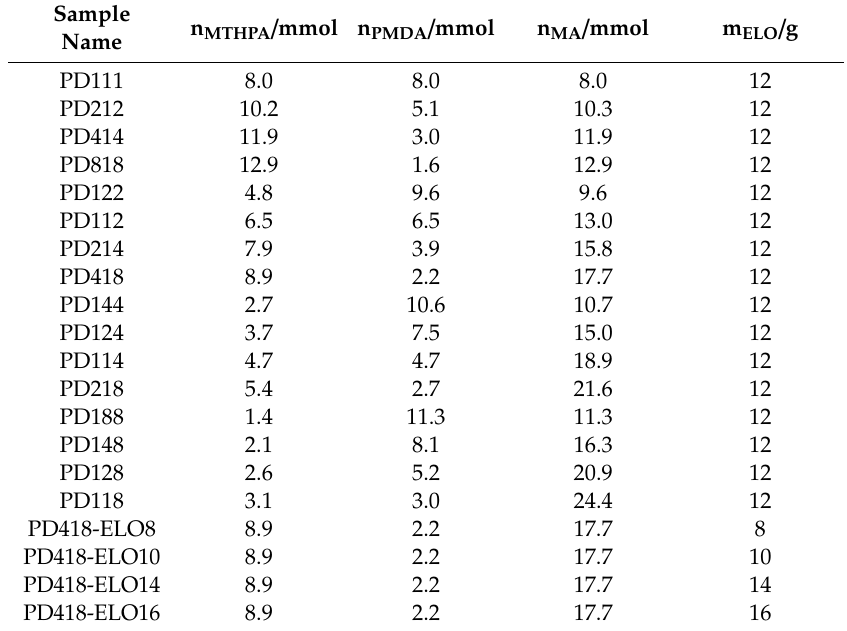
Table 1. Chemical amounts of methyltetrahydrophthalic anhydride (MTHPA) n MTHPA , pyromellitic dianhydride (PMDA) n PMDA , maleic acid (MA) n MA and mass of epoxidized linseed oil (ELO) m ELO of the